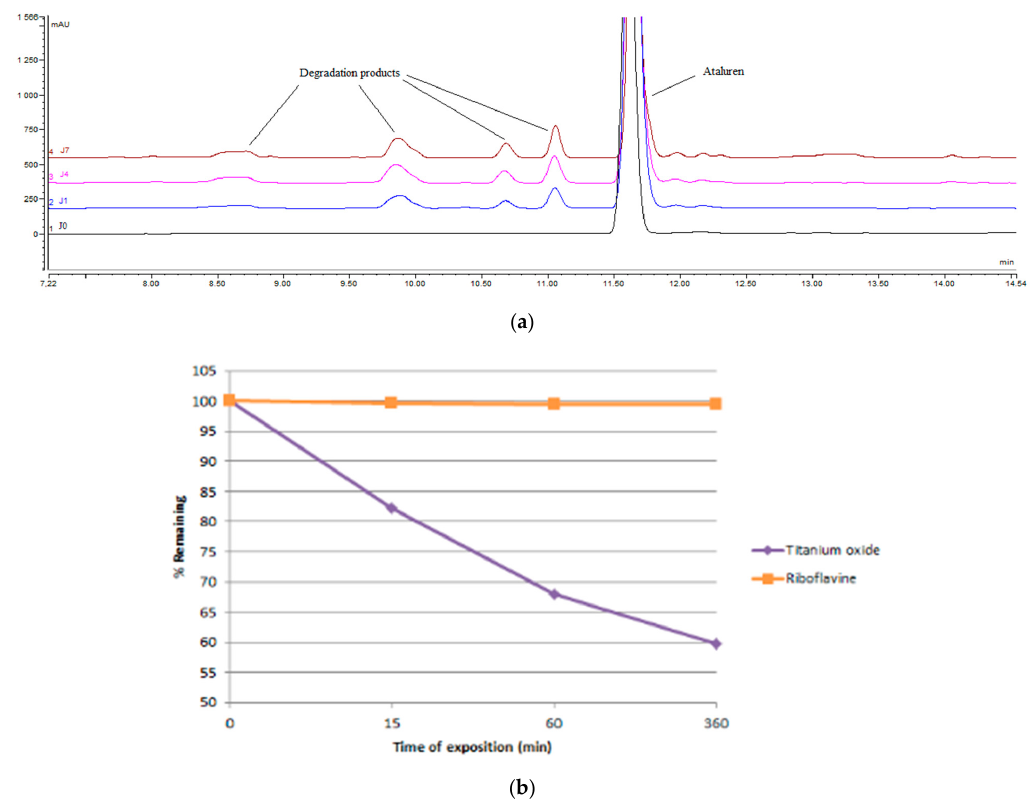
Figure 3. ( a ) Chromatograms of ataluren obtained at day 0 (black, control), 1 day (blue), 4 days (pink), and 7 days (orange) and its degradation products when exposed to 15% H 2 O 2 ; ( b ) Indirect photolysis of ataluren . In the direct photolytic stress condition, ataluren was not degraded (Table 4). Table 4. Direct photolysis of ataluren. The measurements corresponded to a visible intensity of